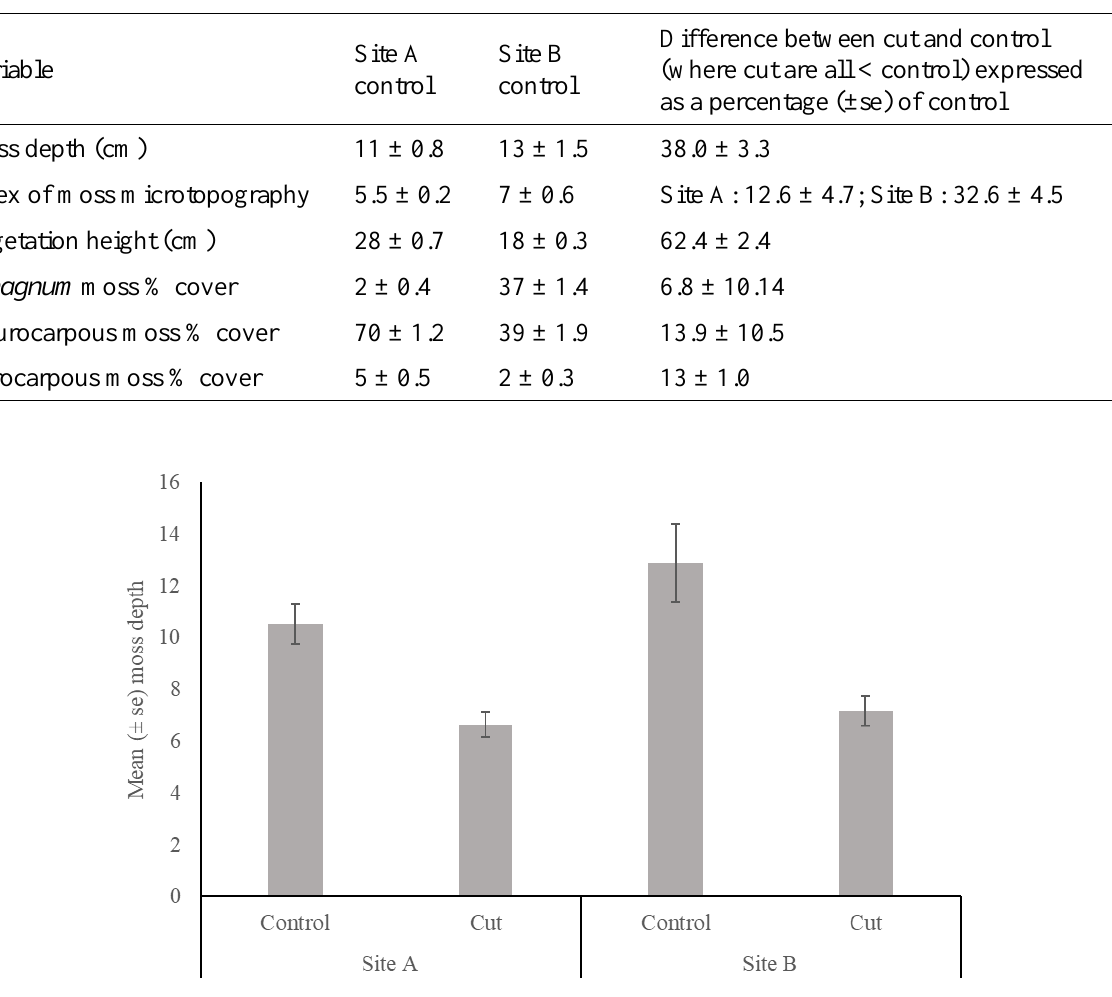
Table 2. Mean (± SE) moss depth, index of moss microtopography, vegetation height and % cover of Sphagnum , pleurocarpous and acrocarpous mosses cover from ten control plots on each of two sites; and difference between cut and control plots as a percentage (± SE) of those control values. Values in cut plots were all lower than those in control plots.